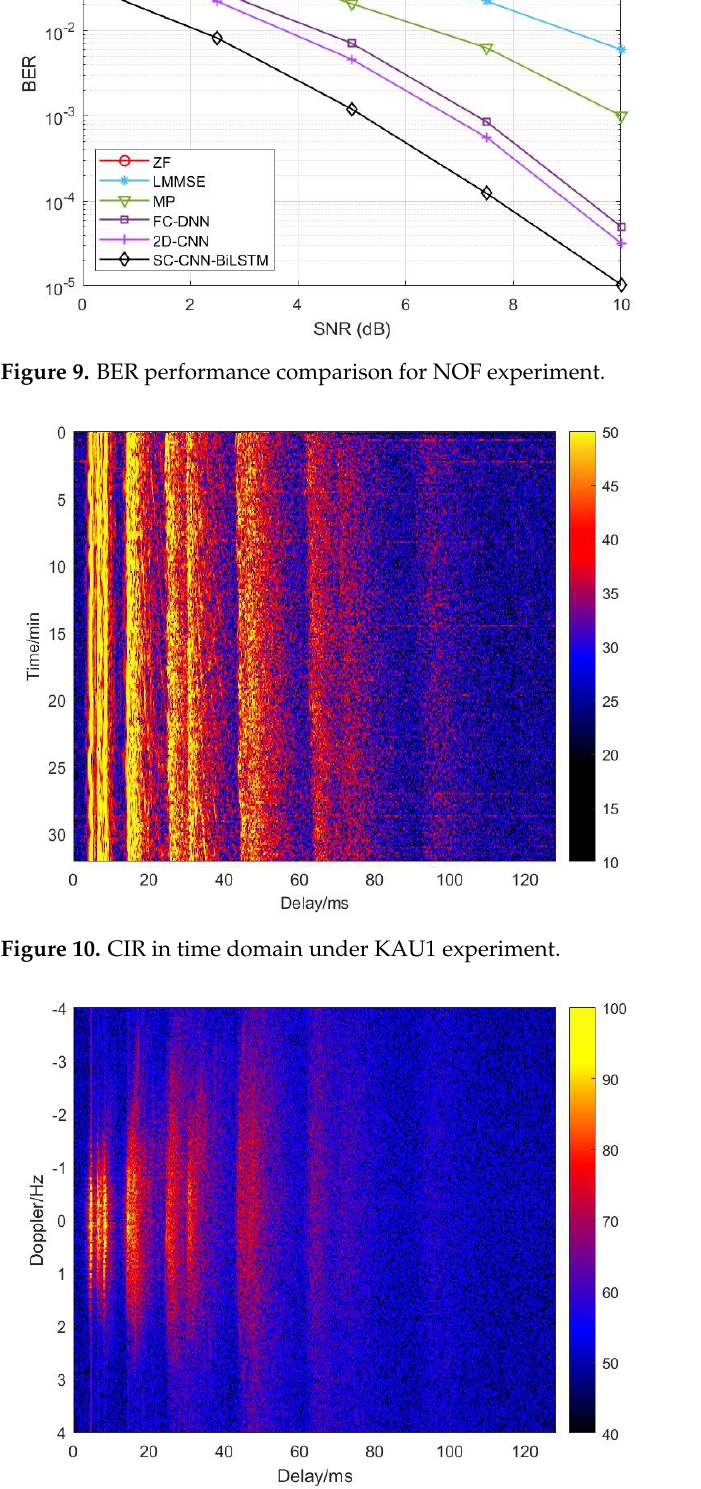
Figure 11. CIR in DD domain under KAU1